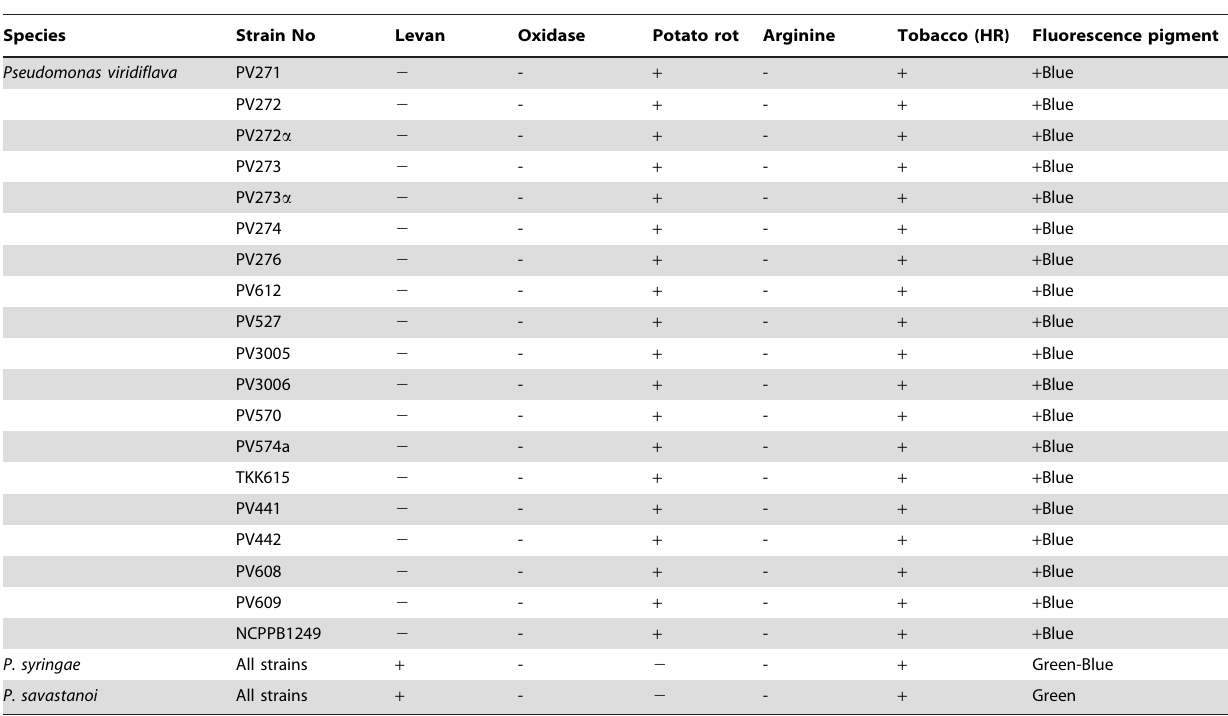
Table 2. LOPAT tests of eighteen local (Crete, Greece) P. viridiflava isolates along with P. viridiflava reference strain NCPPB1249 and other